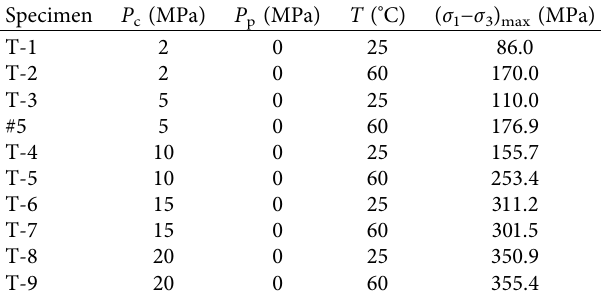
Table 1: Conventional triaxial experiments considering the effects of confining pressure and temperature.